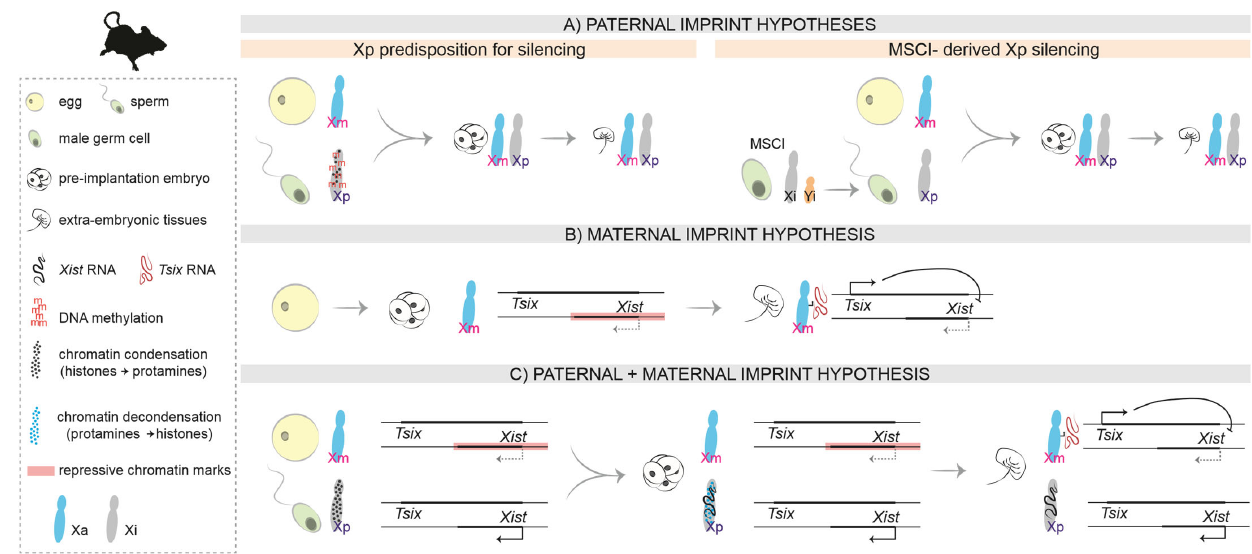
Figure 2. Hypotheses on the molecular nature of the imprint in mice. ( A ). Paternal imprint: The Xp inherits a predisposition for silencing from its life cycle in the male. ( B ). Maternal imprint: In the preimplantation embryo, repressive chromatin marks on the Xm (including the Xist promoter region) prevent Xist expression on the Xm. In the extra ‐ embryonic tissues of the post ‐ implantation embryo, Tsix expression prevents Xist upregulation in cis . ( C ). Paternal and maternal imprint: A combination of both hypotheses, also considering the different chromatin condensation states of the Xp in the sperm and in the paternal pronucleus after fertilization.